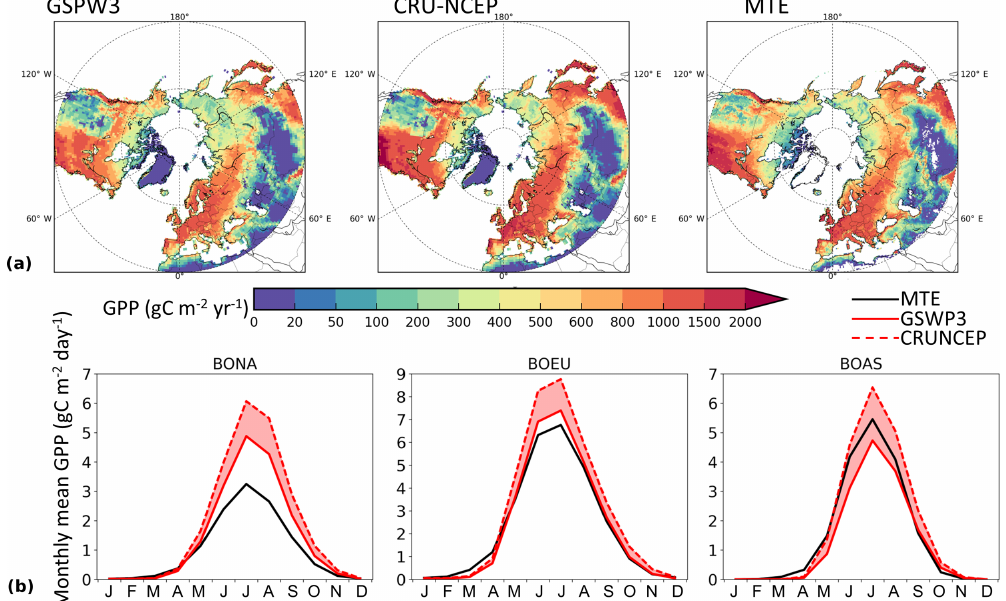
Figure 14. (a) Simulated annual GPP (gCm − 2 day − 1 ) from the two climate forcings, compared to the data-driven MTE-GPP, averaged over the period 2000–2007. (b) Monthly mean seasonal GPP (gCm − 2 day − 1 ) simulated with the two forcings compared to MTE-GPP over the three high-latitude sub-regions (shown in Fig. 2a), averaged over the same period.